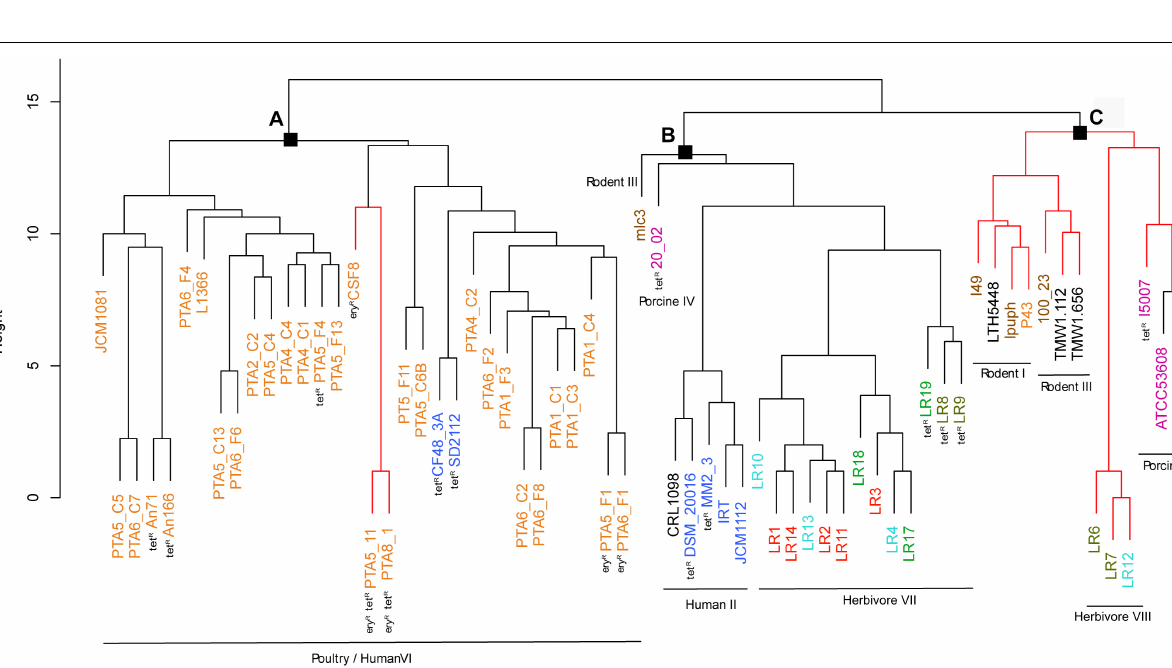
Frontiers in Microbiology |